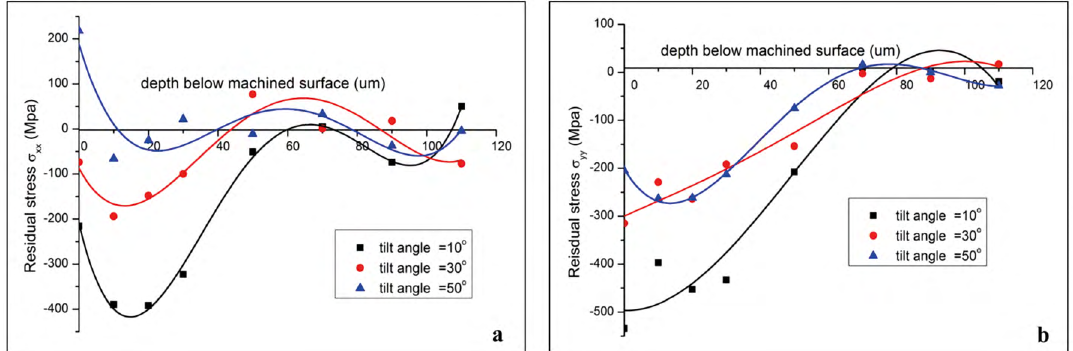
, (b) σ , ( a =0.3mm, a =0.2mm, V =60m/min, f =0.06mm/rev, lead xx yy p e eff